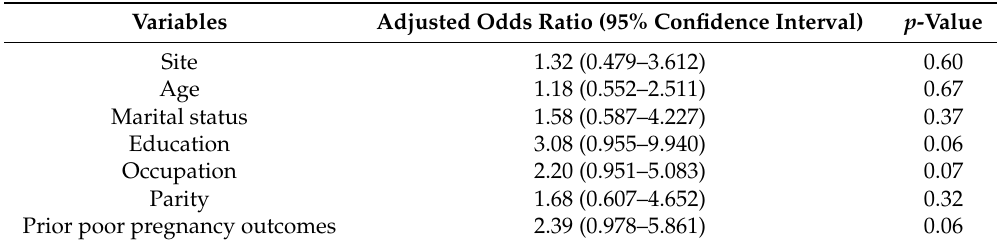
Table 4. Multivariate logistic